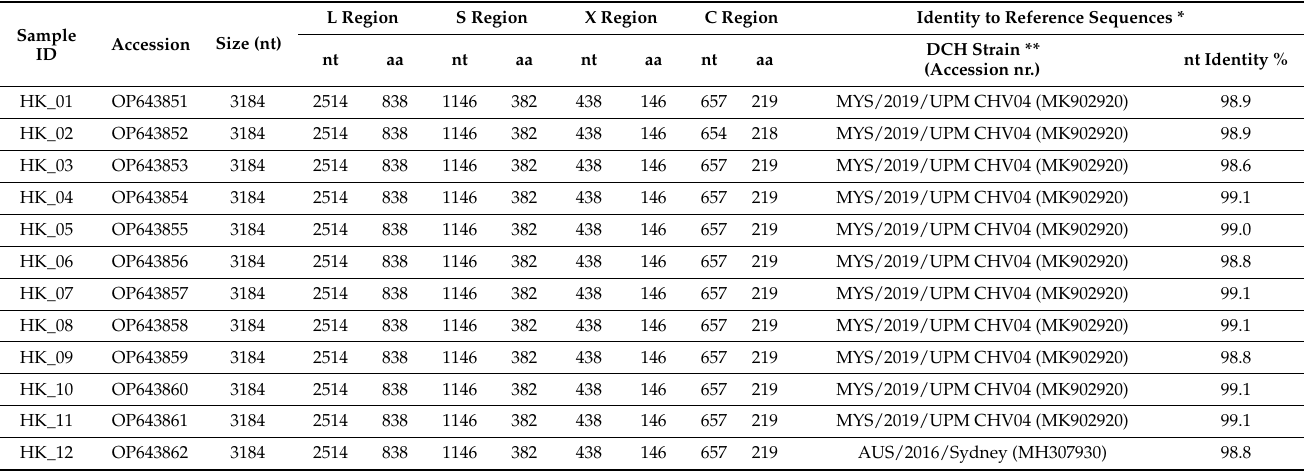
Table 3. Genomic features of complete genomes of the domestic cat hepadnavirus (DCH) strains sequenced in this